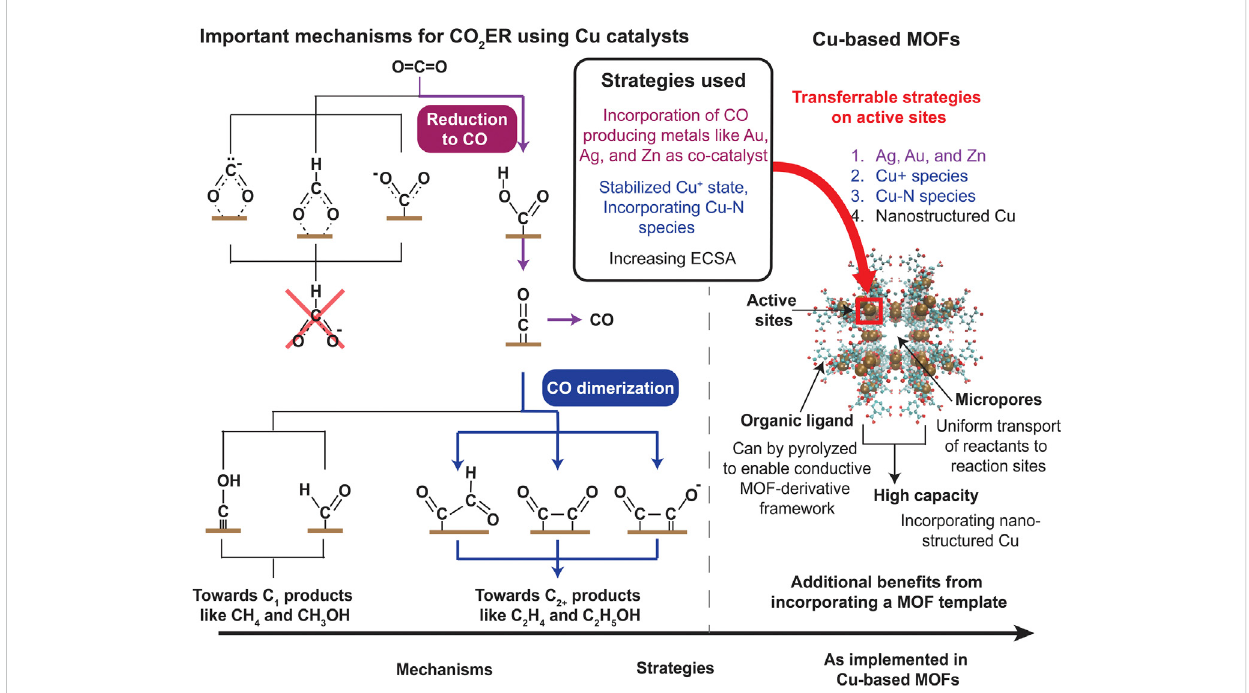
FIGURE 1 A partial CO 2 ER pathway indicating major reactions process (Hori et al., 1994; 1997; Peterson et al., 2010; Kuhl et al., 2012; Cheng et al., 2015; Kortlever et al., 2015; Montoya et al., 2015; Feaster et al., 2017; Chernyshova et al., 2018; Garza et al., 2018; Lum et al., 2018; Liu et al., 2019; Nitopi et al., 2019). Mechanisms that play a critical role in the production on C 2+ products via CO 2 ER on Cu-based catalysts along with strategies used to enhance them are speci fi cally highlighted. These strategies can be implemented in a Cu-based MOF system; the chemically tunable active sites along with additional advantages of a MOF template for catalysis highlights the ability of Cu-based MOFs to produce C 2+ products via CO 2